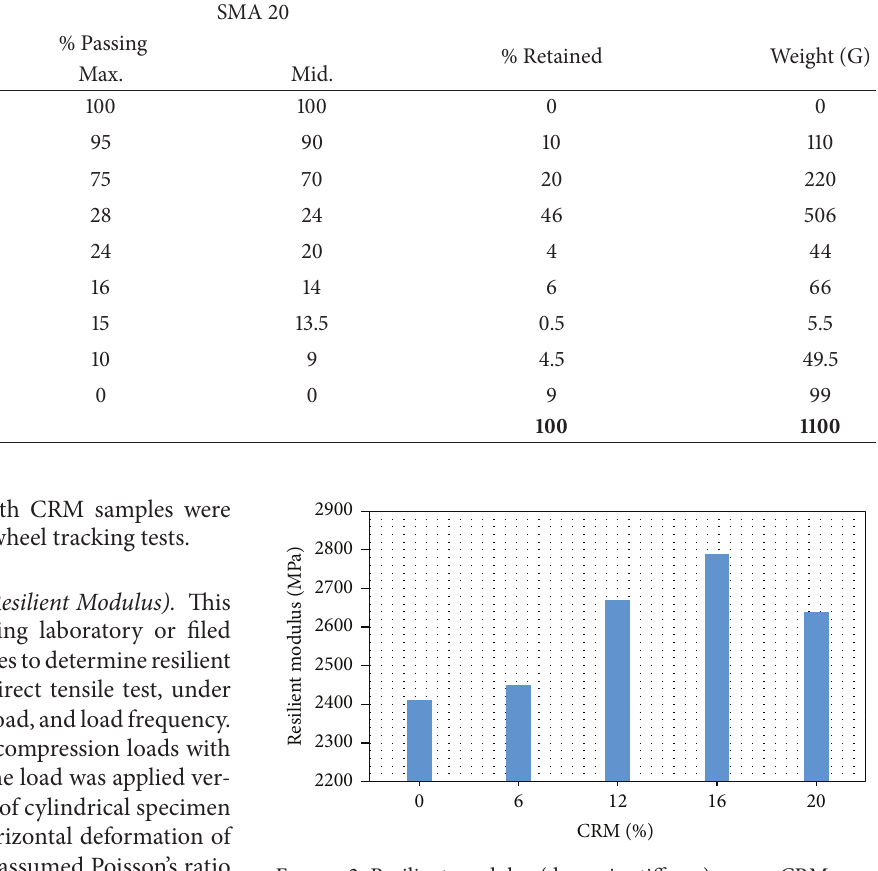
Figure 2: Resilient modulus (dynamic stiffness) versus CRM con-